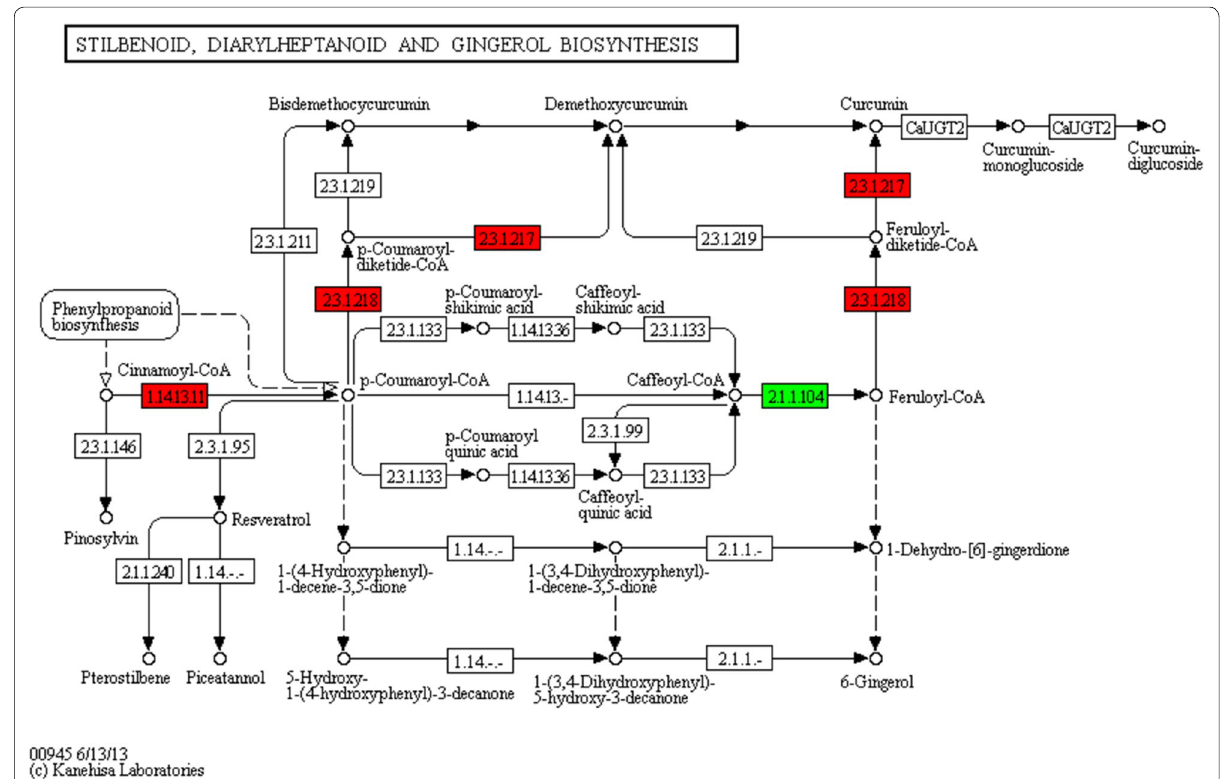
Fig. 5 Differentially expressed genes (DEGs) involved in the “stilbenoid, diarylheptanoid and gingerol biosynthesis” pathway. The red col- umns indicate genes expressed at a significantly high level in fibrous roots; the green columns indicate genes expressed at a significantly high level in rhizomes. This color-coded map of DEGs corresponds to map00945 in the KEGG database (http://www.genome.jp/dbget-bin/www_